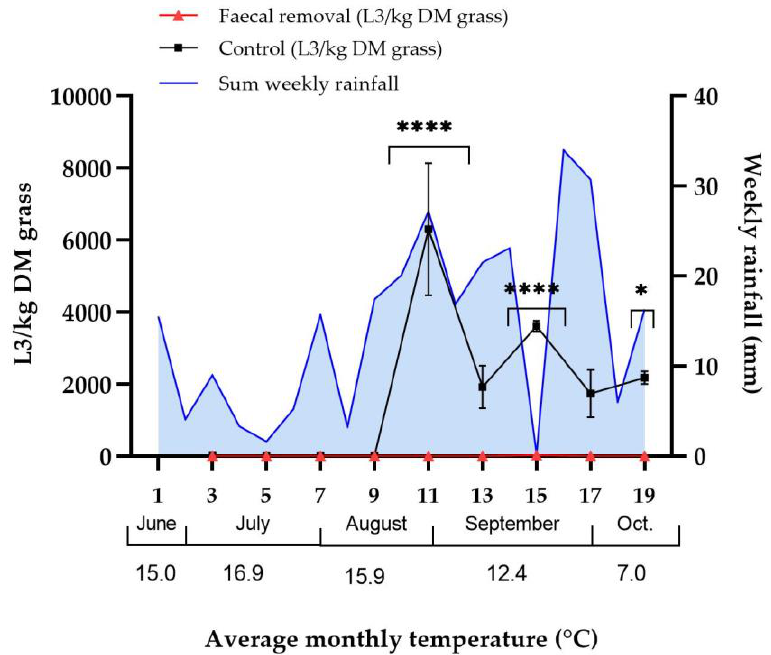
Figure 6. Faecal removal study, 2017: Larval yield (mean L3/kg dry matter of grass (DM) ± SD) in the faecal removal pasture (pasture A) and control pasture (pasture B) and weekly rainfall (mm) in each sampling week (designated 1 – 19 on the x-axis). The average monthly temperature is shown below the x-axis. * p < 0.05; **** p < 0.0001. Due to zero larval yield at all time points in pasture A apart from sampling points 11 and 15 (6 and 55 L3/kg DM, respectively), no error bars are shown for pasture A.